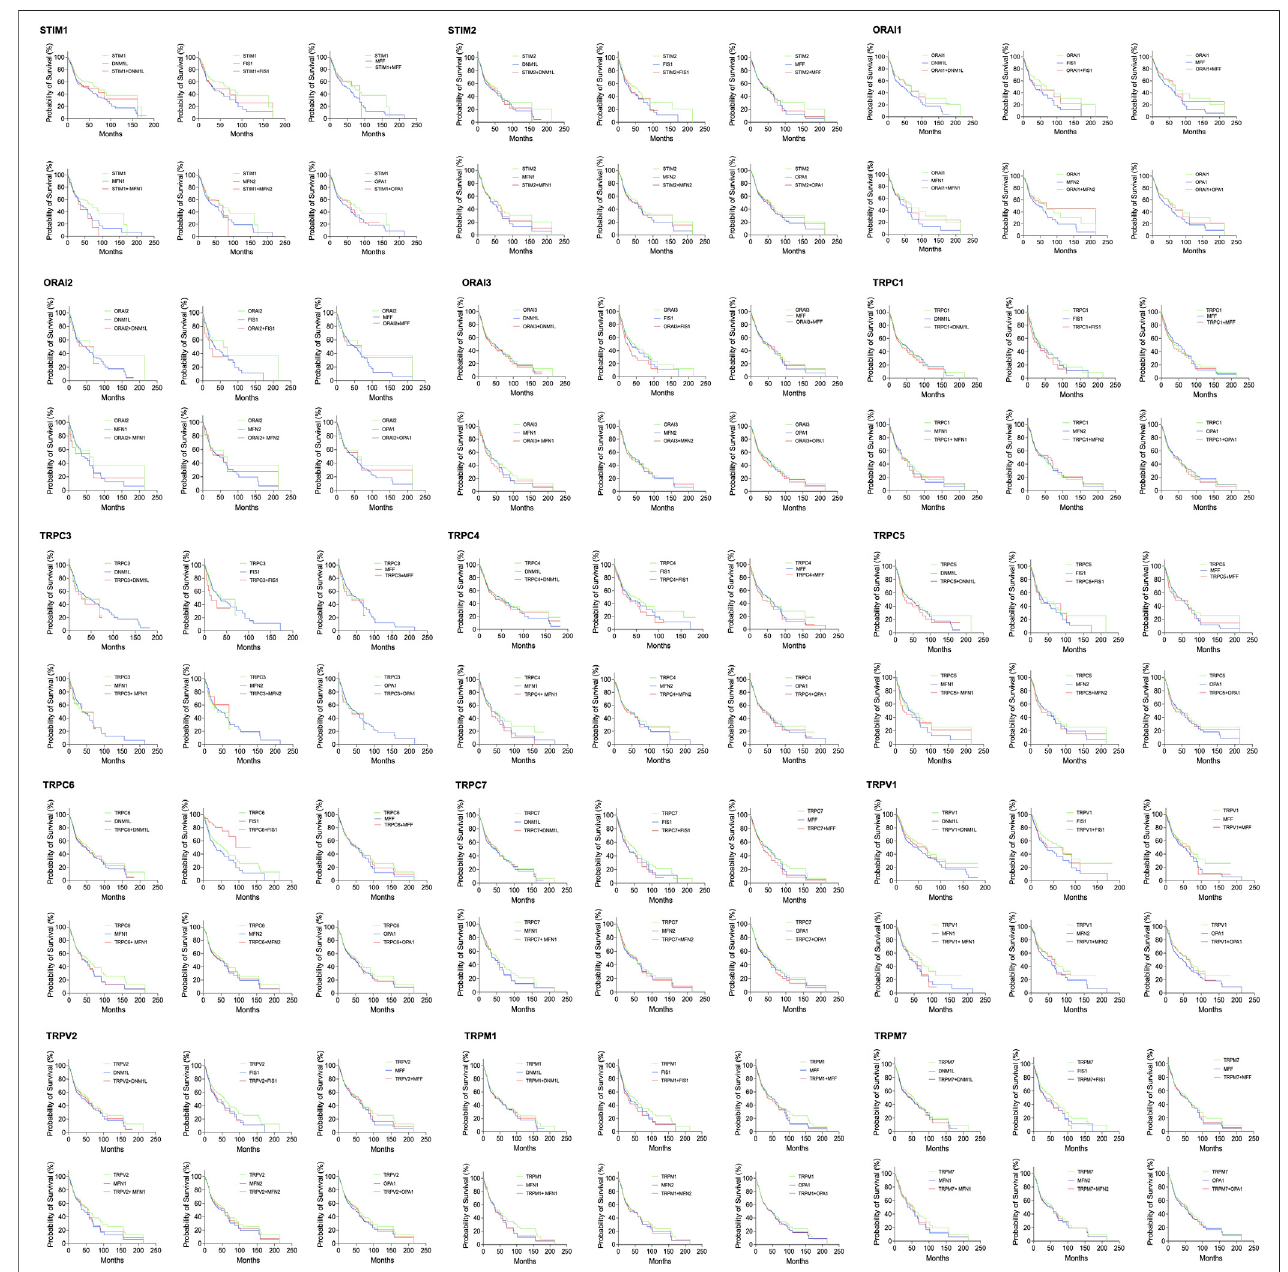
FIGURE 8 | Survival analysis among Head neck cancer patients expressing altered levels of SOCs in conjunction with MDGs. The survival data from TCGA was downloaded using TCGA biolinks package built for R statistical environment. The survival data for expression levels of each SOCs in conjunction with MDGs is plotted.